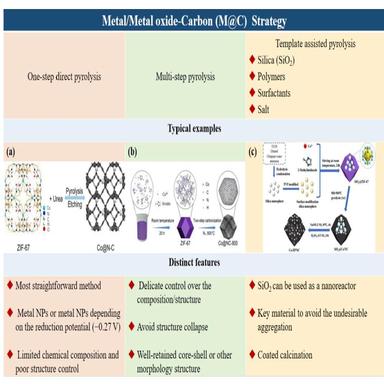
Fabrication strategies of MOF-derived Metal/Metal oxide carbon. (a) One-step pyrolysis strategy. Copyright 2018 Elsevier. (b) Multi-step pyrolysis strategy . Copyright 2020 Elsevier. (c) Template assisted strategy . Copyright 2022 Elsevier.